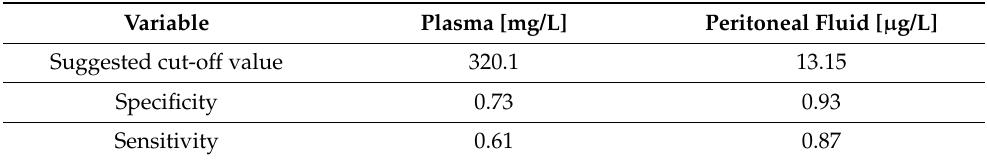
Figure 4. The ROC curve analysis for diagnostic efficacy of both fibronectin in plasma and peritoneal fluid for endometriosis. Table 5. Suggested cut-off values and estimated specificity and sensitivity of plasma and peritoneal fluid fibronectin.